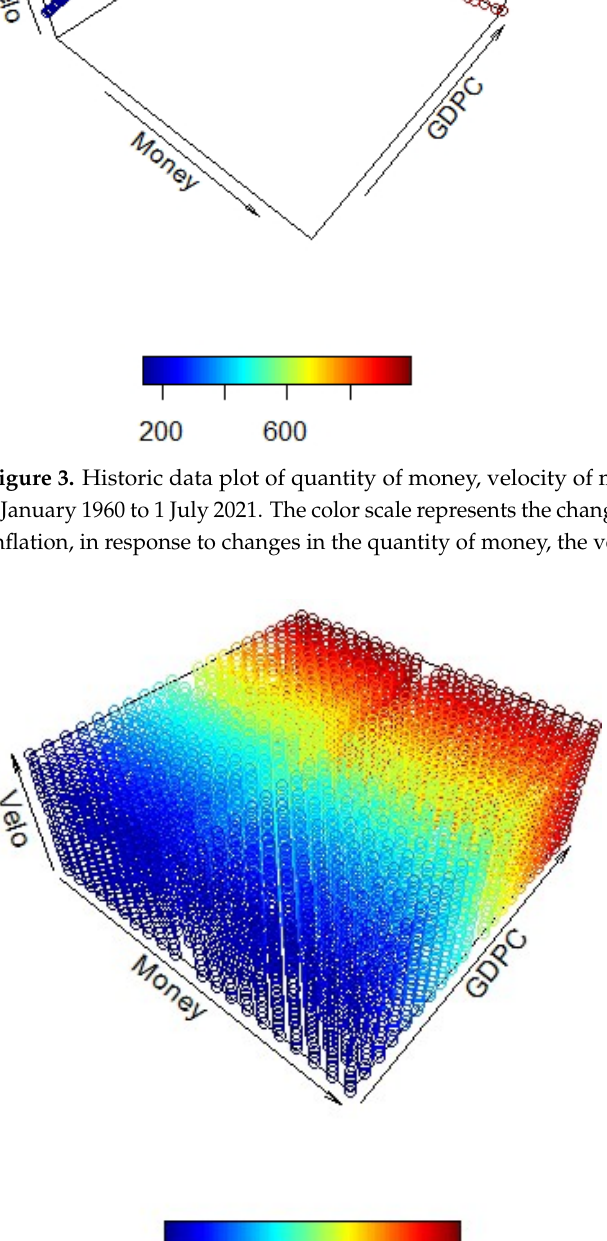
Figure 4. Ceteris paribus analysis of the holistic quantity equation. The color scale represents the change of the GDP deflator, with respect to inflation, in response to changes in the quantity of money, the velocity of money, and GDP (GDCP1). the velocity of money, and GDP